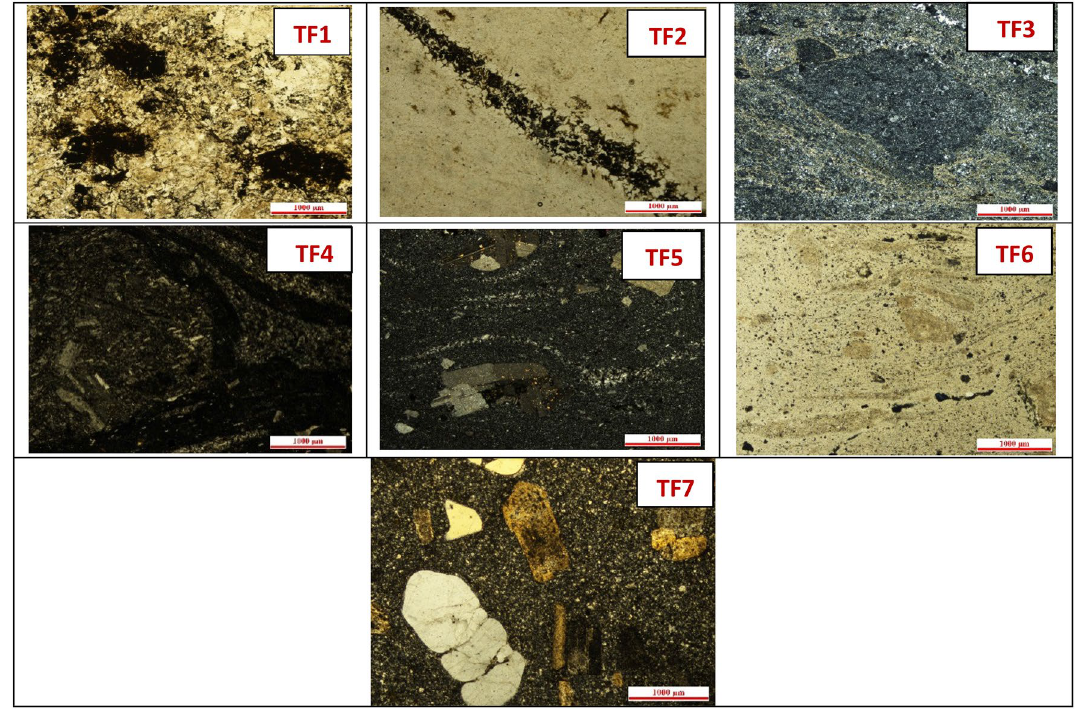
Figure 1. The petrographic description of the rhyolite ignimbrites tuffs